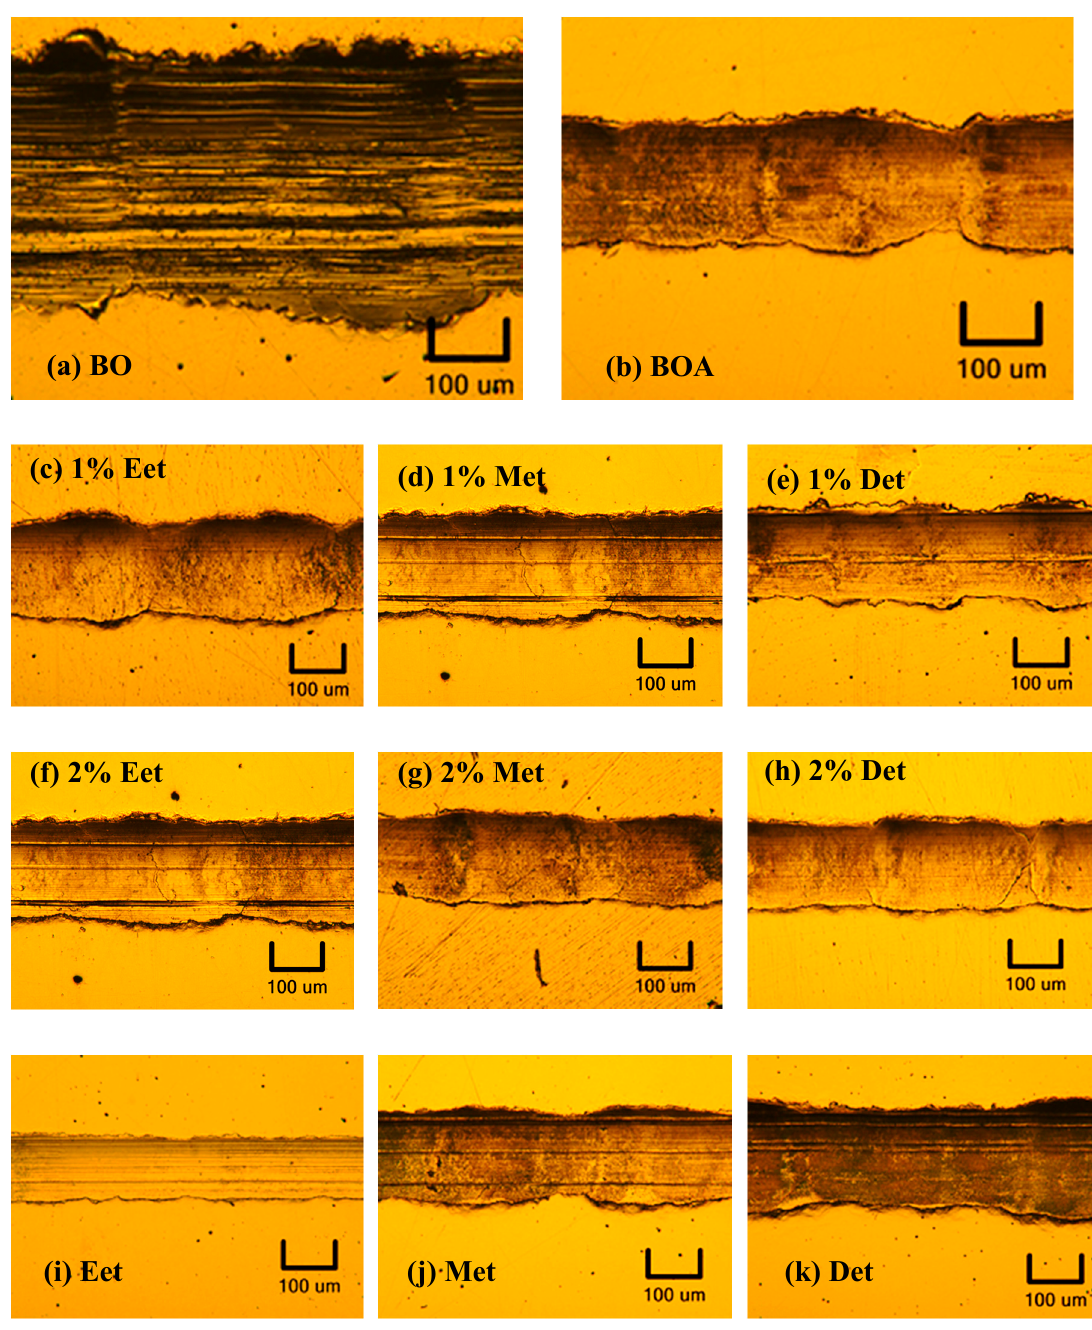
Figure 7. Optical images of worn surfaces on steel surfaces after tests lubricated with ( a ) BO, ( b ) BOA, ( c ) 1 wt.% Eet + BO, ( d ) 1 wt.% Met + BO, ( e ) 1 wt.% Det + BO, ( f ) 2 wt.% Eet + BO, ( g ) 2 wt.% Met + BO, ( h ) 2 wt.% Det + BO, ( i ) Eet, ( j ) Met, and ( k ) Det.